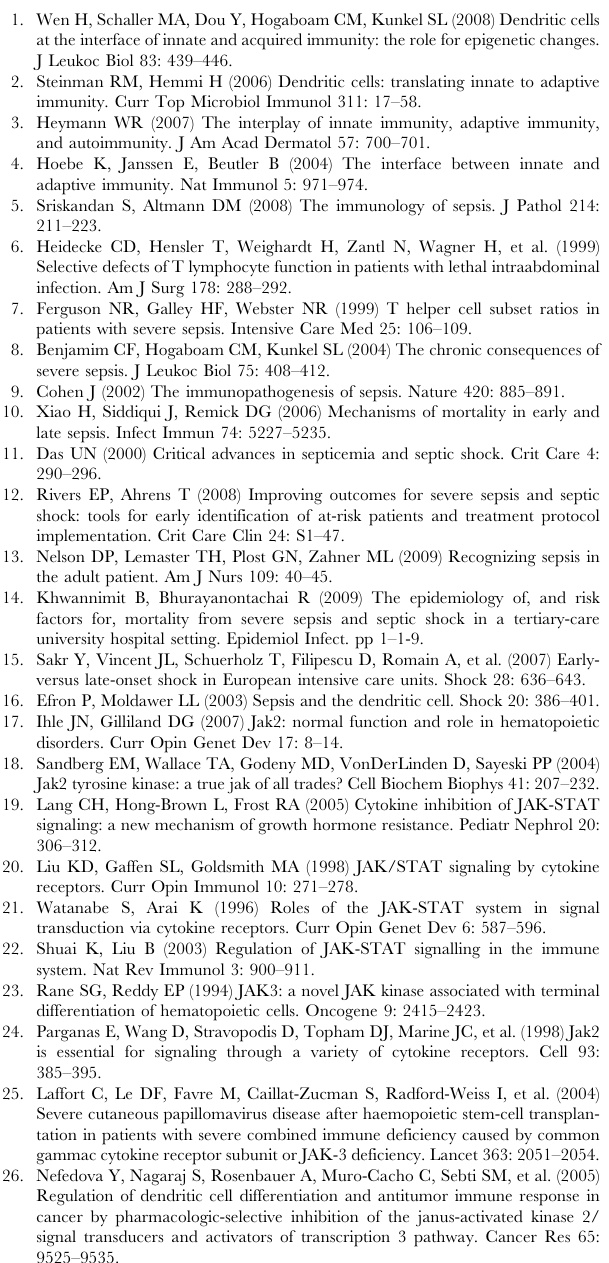
Figure S7 Western blot analysis of the activation states of